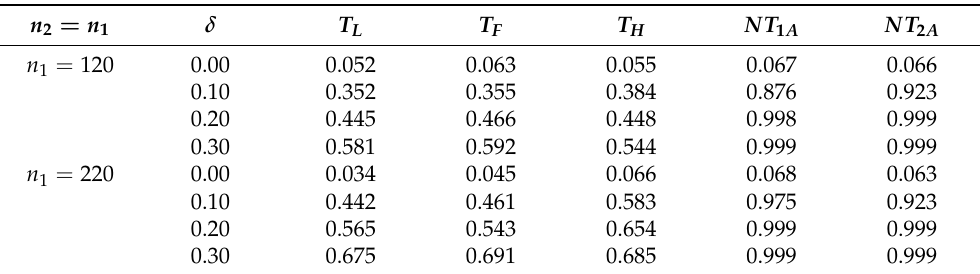
Table 2. Size and power of five methods in Setting 2 (mean difference lies in middle part µ 2 [ 11 : 16 ] = µ 1 [ 11 : 16 ] + δ